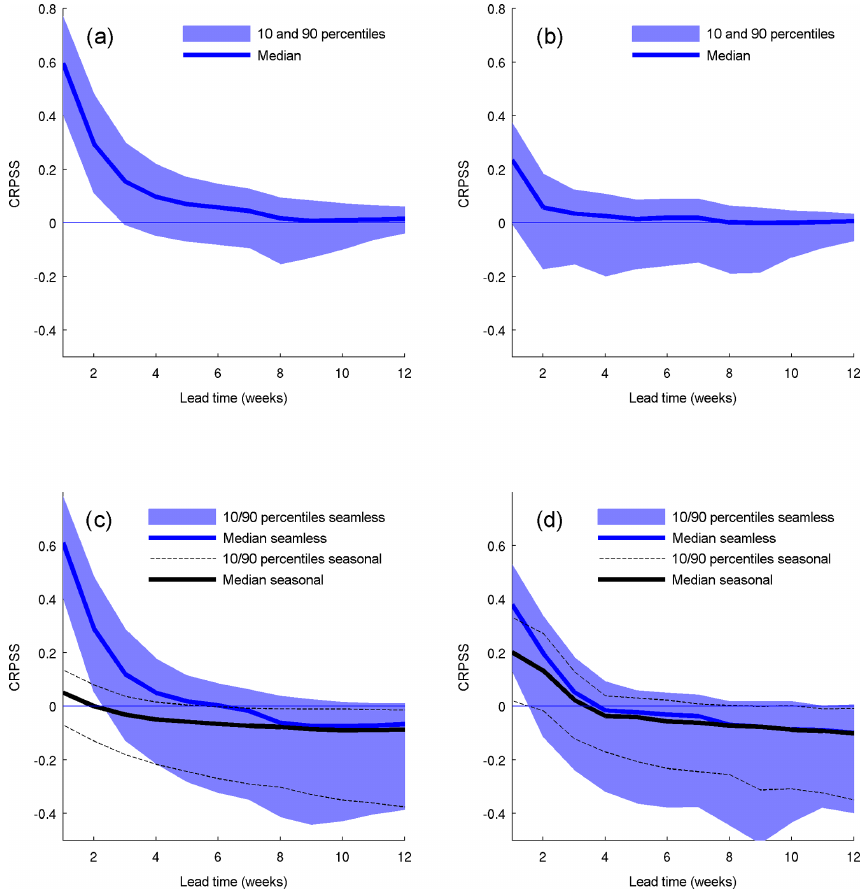
Figure 3. Continuous ranked probability skill score (CRPSS) for (a) merged forecast against seasonal forecast for all start dates evaluated over the 679 basin outlet points; (b) as in (a) but only for the first merged forecast of each month; (c) merged forecast against climatology for all lead times in blue and (d) as in (c) but for the first merged forecast in the month. The shaded blue area denotes the 10–90 percentile of the CRPSS and the blue line the median. The black solid (dotted) lines in (c) and (d) denote the mean and 10–90th percentiles of the CRPSS of the seasonal against the climatological